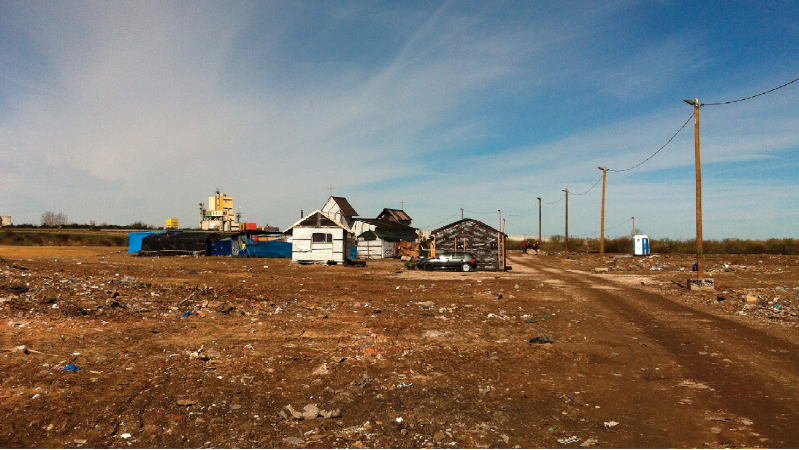
Figure 3. Public buildings saved from demolition, the “Jungle,” Calais, France, April 2016. Photo by